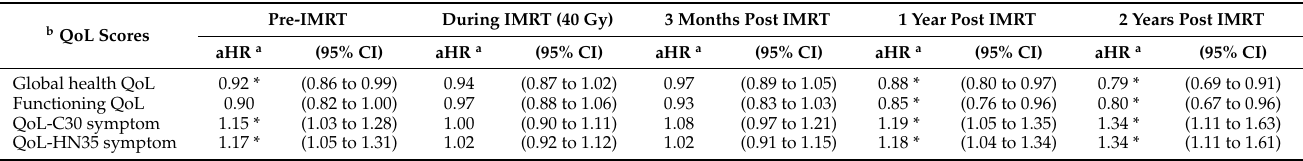
Table 4. Adjusted hazard ratios (aHR) of mortality associated with continuous quality of life (QoL) scores at different time points of IMRT.